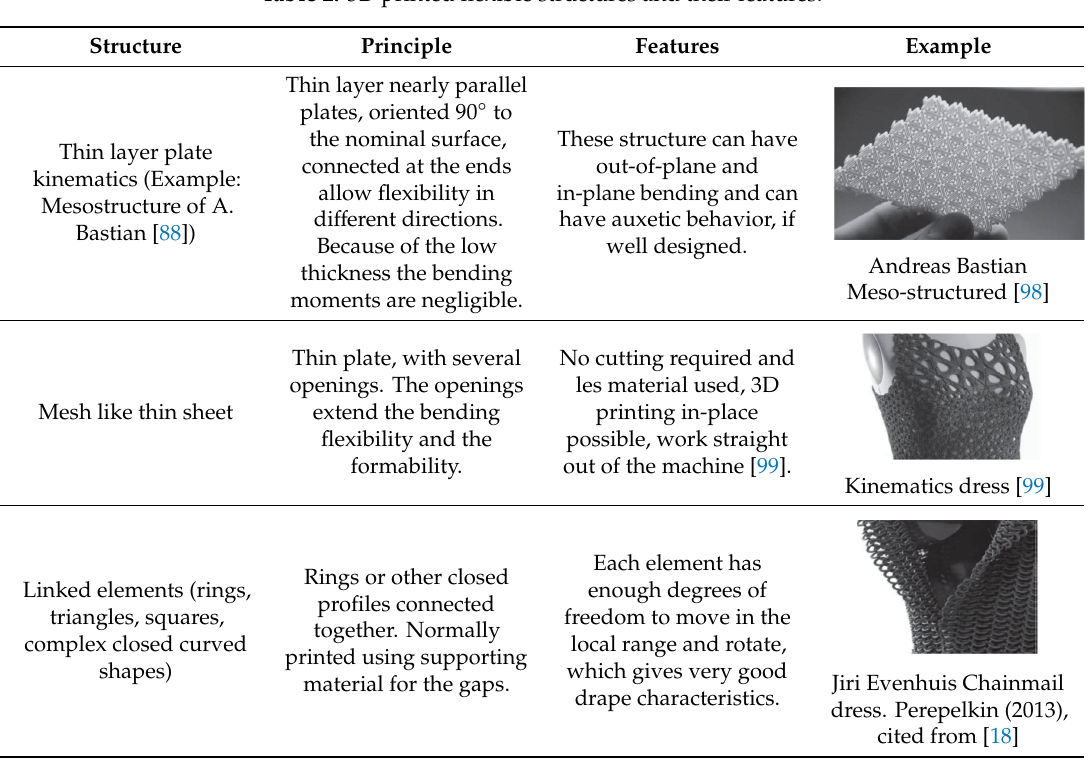
Table 2. 3D printed flexible structures and their features.